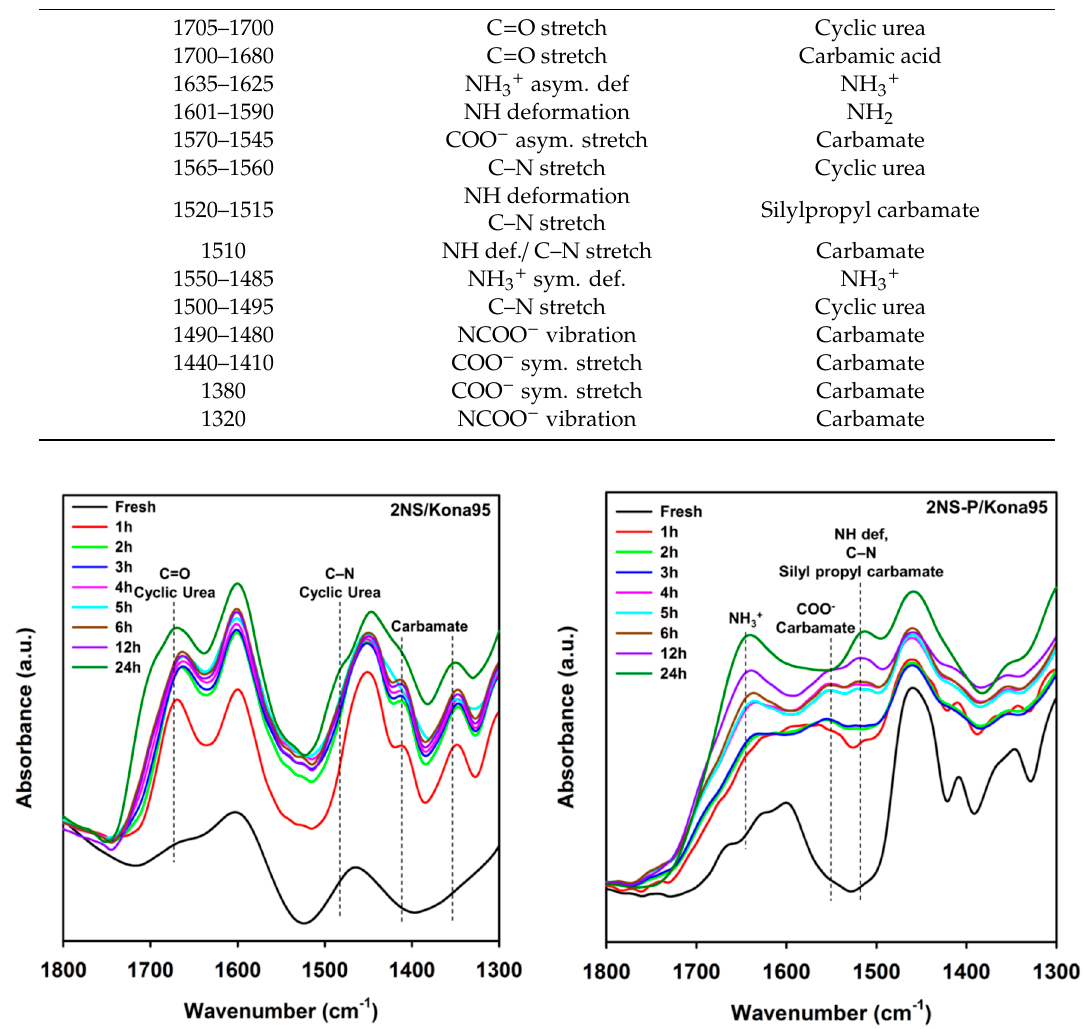
Figure 5. Changes in the in situ FT-IR spectra of ( a ) 2NS/Kona95 and ( b ) 2NS-P/Kona95 exposed to 100% CO 2 at 110 °C.